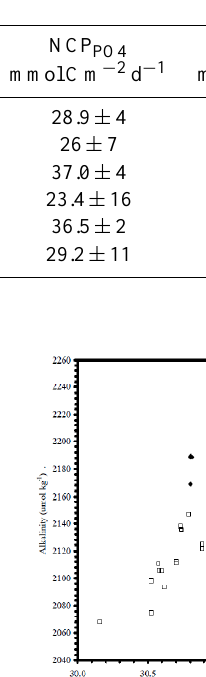
Table 4. NCP inmmolesCm − 2 d − 1 by domain in 2008, where NC indicates the northern coastal domain, SC indicates the southern coastal domain, NM indicates the northern middle domain, SM indicates the southern middle domain, and SO indicates the southern outer domain.